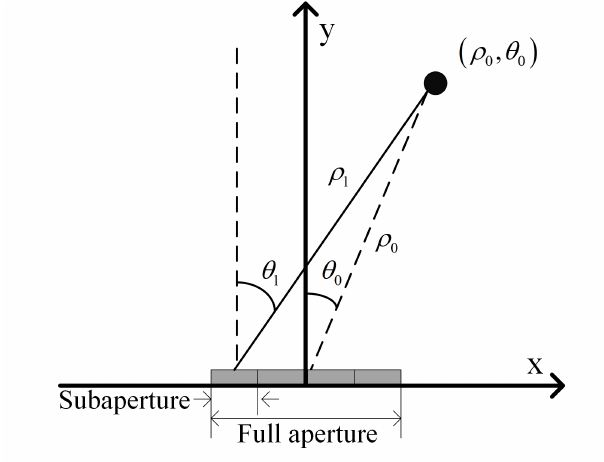
Figure 12. Schematic diagram of geometric